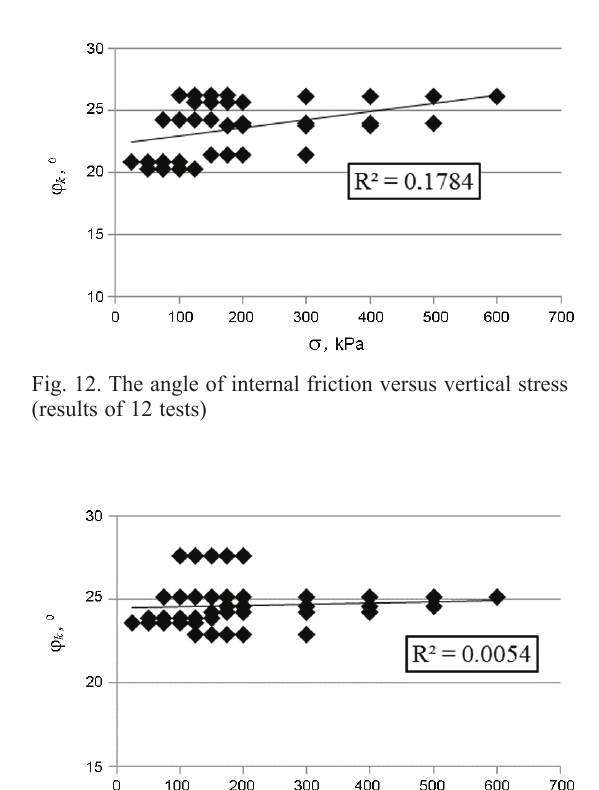
Fig. 17. The angle of internal friction versus vertical stress (results of 27 tests)